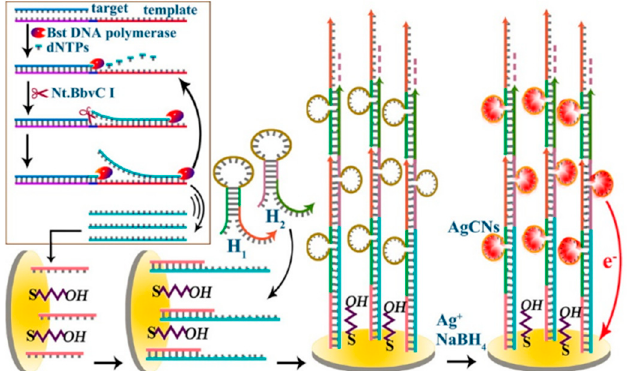
Figure 3. Schematic representation of ultrasensitive and label-free electrochemical detection of miRNA-199a based on in situ generated AgNCs by coupling TAPNR with HCR amplifications [49]. Copyright 2015 American Chemical Society.